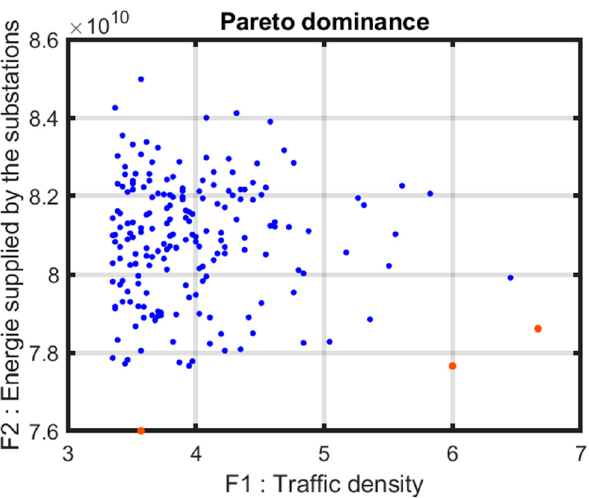
Figure 13. Empirical Pareto plot. Each dot represents an acceptable solution. Blue dots represent dominated solutions and red dots represent compromised solutions.